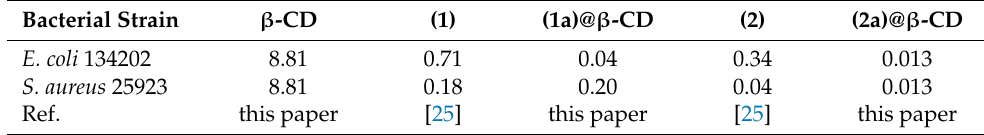
Table 3. The MIC values (mM) for β -CD, precursors, and inclusion species. Bacterial